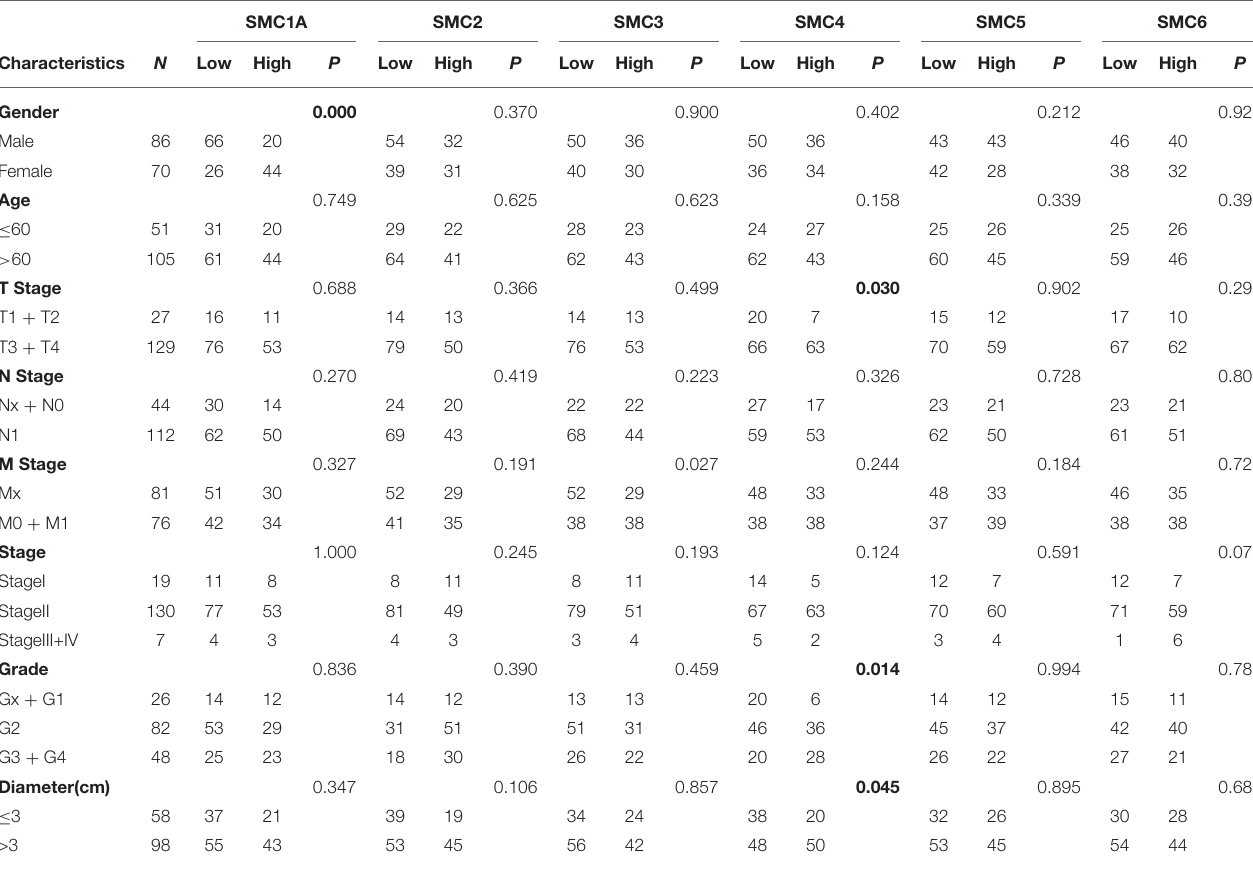
TABLE 1 | Clinicopathologic parameters and the expression of SMC gene family members in PAAD. SMC1A SMC2 SMC3